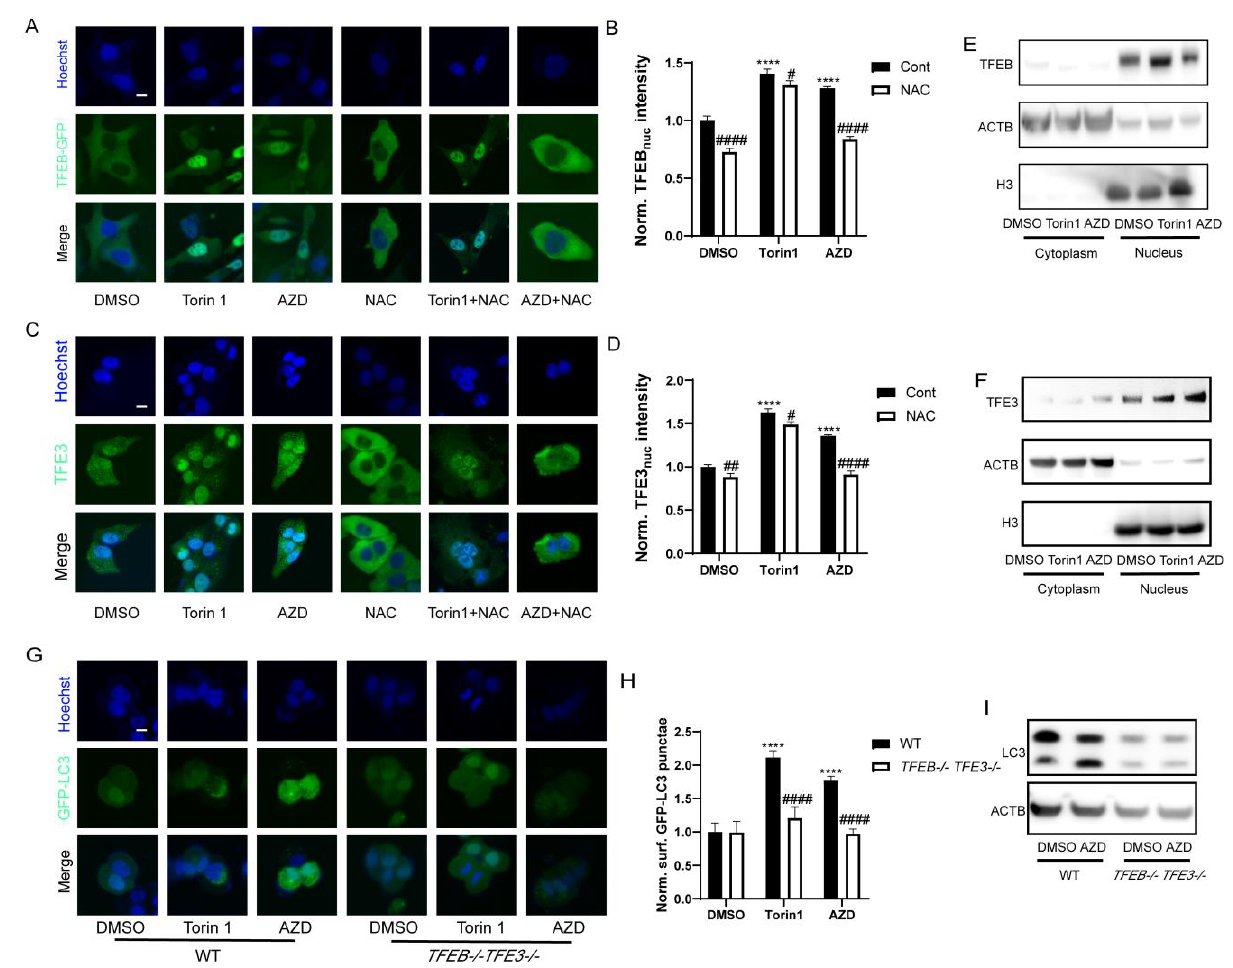
FIGURE 5: AZD induces TFEB/TFE3 activation. (A-F) TFEB-GFP-expressing or wild type U2OS cells were treated with Torin 1 (300 nM) or AZD (40 µM) combined or not with NAC (3 mM) for 6 h . The average nuclear intensity of TFEB was measured (A, B) , TFE3 translocation was as- sessed by immunostaining (C, D) , and (E) TFEB and (F) TFE3 in the cytoplasm and nucleus were assessed by Western blot. (G) Western blot was performed for measuring the expression of TFEB and TFE3 in U2OS cells with or without TFEB-/-TFE3-/- double-knockout treated with AZD. Scale bars equal 10 μm. (*P < 0.05, **P < 0.01, ***P < 0.001,* ***P<0.0001 vs. DMSO ; #P < 0.05, ##P < 0.01, ###P < 0.001 ， #### P < 0.0001 vs. Cont or